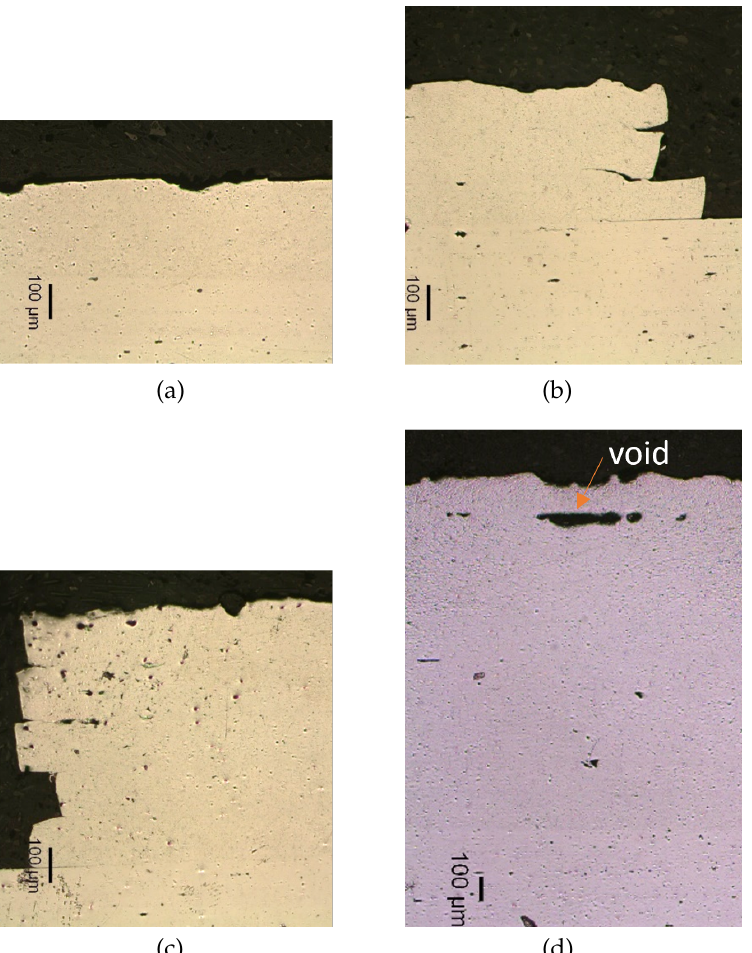
Figure 6. Optical images of ( a ) 2-, ( b ) 3-, ( c ) 5-, and ( d ) 10-layer Al 6061-H18 welds constructed on a 12.7 mm (0.5 inch) thick Al 6061-T6 baseplate using the following weld parameters: 32 µ m welder amplitude, 5000 N weld force, and 84.67 mm/s (200 in/min) weld speed.